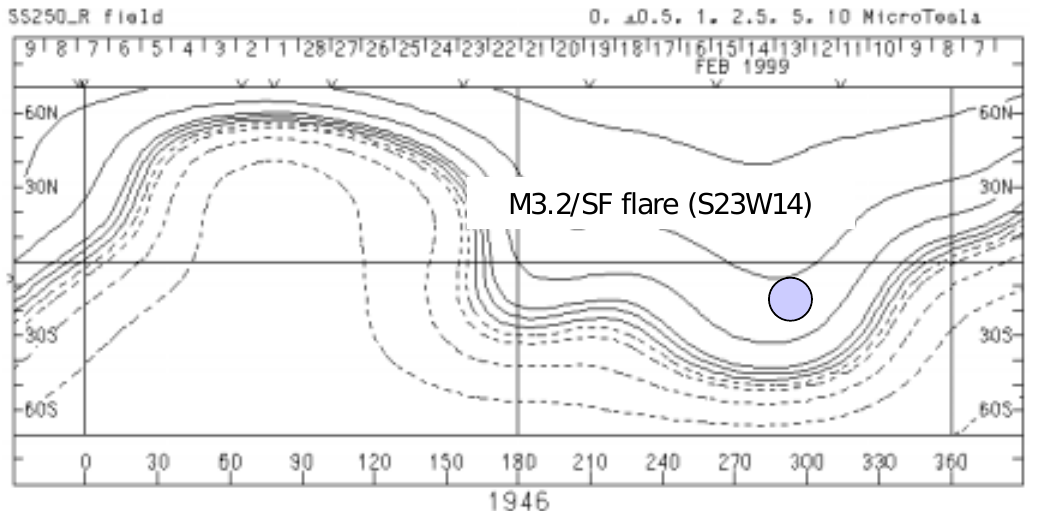
Fig. 10. A source surface map produced by the Wilcox Solar Observatory. The circle shows the location of a M3.2/SF flare associated with the geomagnetic storm no.